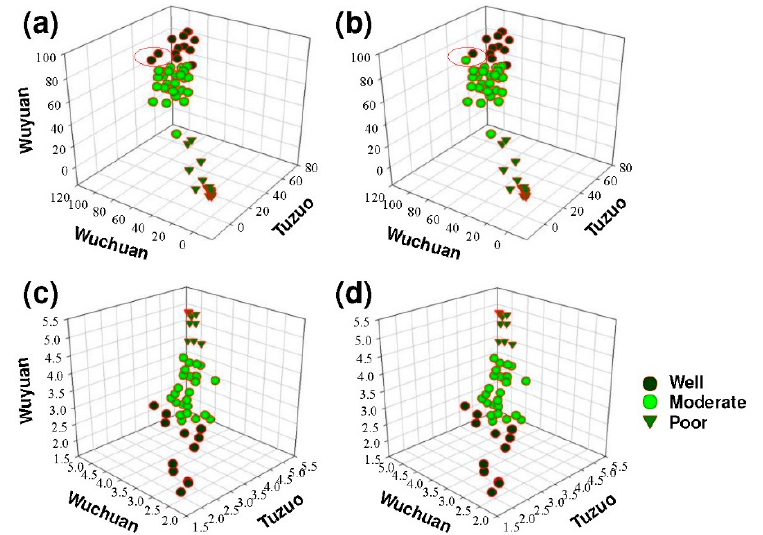
Figure 3. Classification of 56 alfalfa cultivars’ winter hardiness performance into three classes using either the K-means clustering (KMC) or the Bayesian discriminant analysis (BDA) method. Winter hardiness is measured in terms of winter survival rate (WSR) or average score index (ASI) based on field experiments in Wuyuan, Wuchuan and Tuzuo sites in northern China. ( a ) Winter hardiness classes in term of WSR based on the KMC method; ( b ) Same as ( a ) but BDA is used as the classification method; ( c ) Winter hardiness classes in terms of ASI based on the KMC method; ( d ) Same as ( c ) but BDA is used as the classification method. The red circle in ( a ) and ( b ) indicates a misclassification involving cultivar no. 17 (unmarked) into the “ Well ” class by KMC.